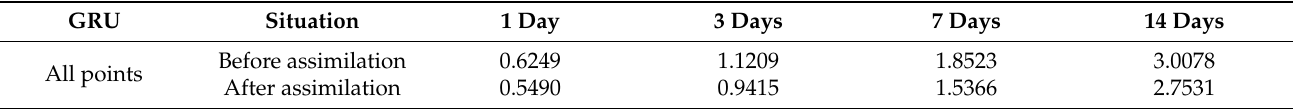
Table 2. Temperature prediction results under different prediction aging before